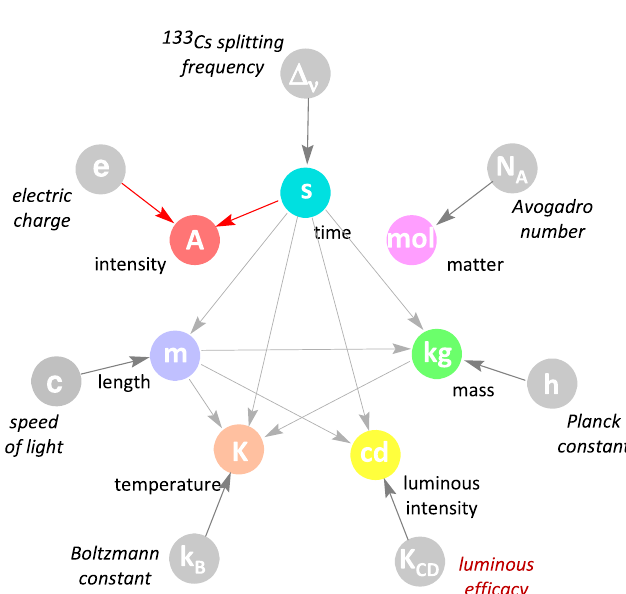
Fig. 5. New organisation of SI